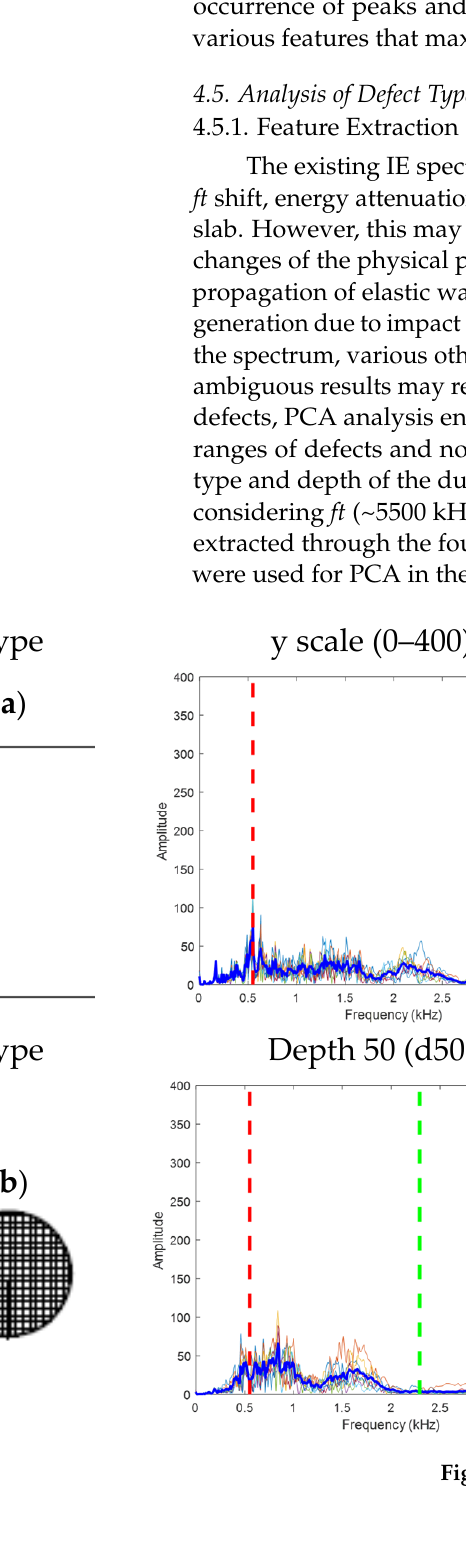
Table 2. Summary of information for natural frequency calculations.